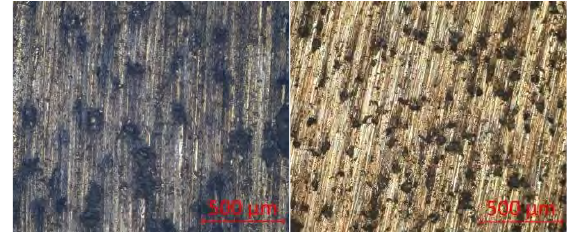
Fig . 5 . Grinding tools with grit size D91 on the left and D64 on the right .